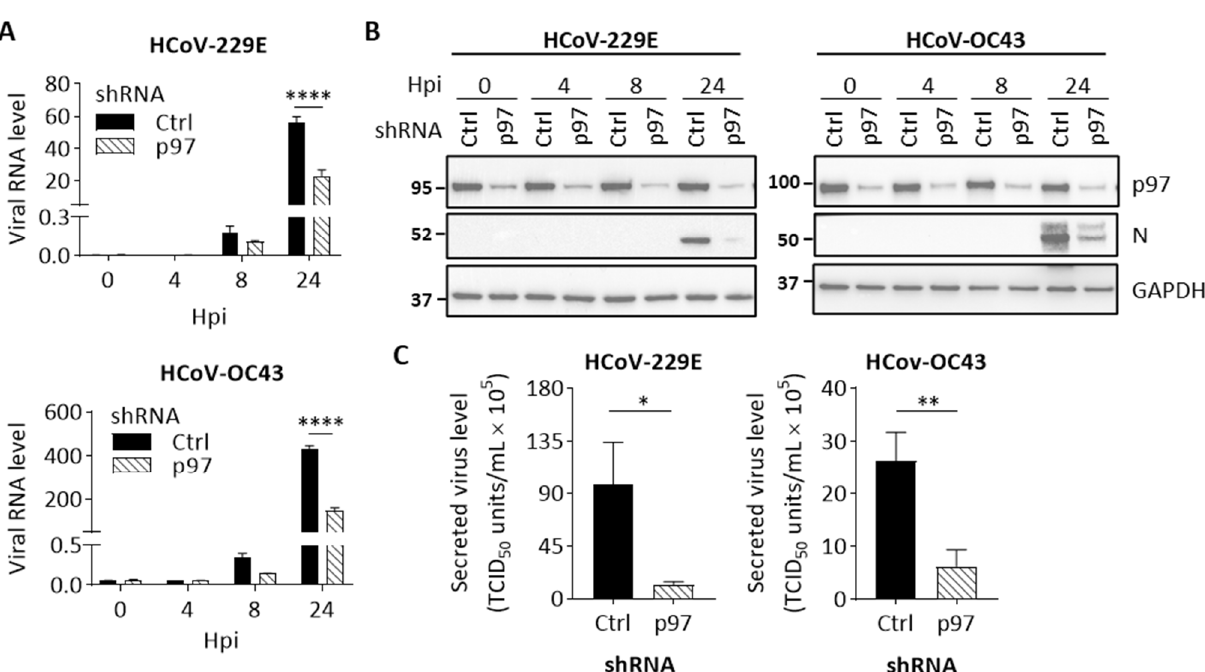
Figure 4. p97 knockdown suppresses HCoV replication in H1299 cells. H1299 cells with inducible control shRNA (Ctrl shRNA) or p97 shRNA were inoculated with Dox (0.5 µ g/mL) for 72 h. Cells were infected with HCoV-229E (MOI 0.05) or HCoV-OC43 (MOI 0.01). After 1 h of infection, cells were washed and harvested at 0, 4, 8, or 24 hpi. Mock-infected cells were harvested at 24 hpi. ( A ) Quantification of viral RNA in cell lysates over time after infection. Data shows viral RNA levels relative to GAPDH. ( B ) Representative western blot images showing the expression of p97, viral N protein, and GAPDH (loading control) in cell lysates across the infection time course. Full-length blots can be found in Supplementary Figure S8. ( C ) Viral titer in culture media collected from HCoV-infected cells at 24 hpi was quantified by determining TCID 50 in H1299 cells. Error bars represent SD ( n = 3). Statistical analysis was conducted with two-way ANOVA for Figure 4A and Student’s t test for Figure 4C: *, p < 0.05; **, p < 0.01; ****, p < 0.0001.